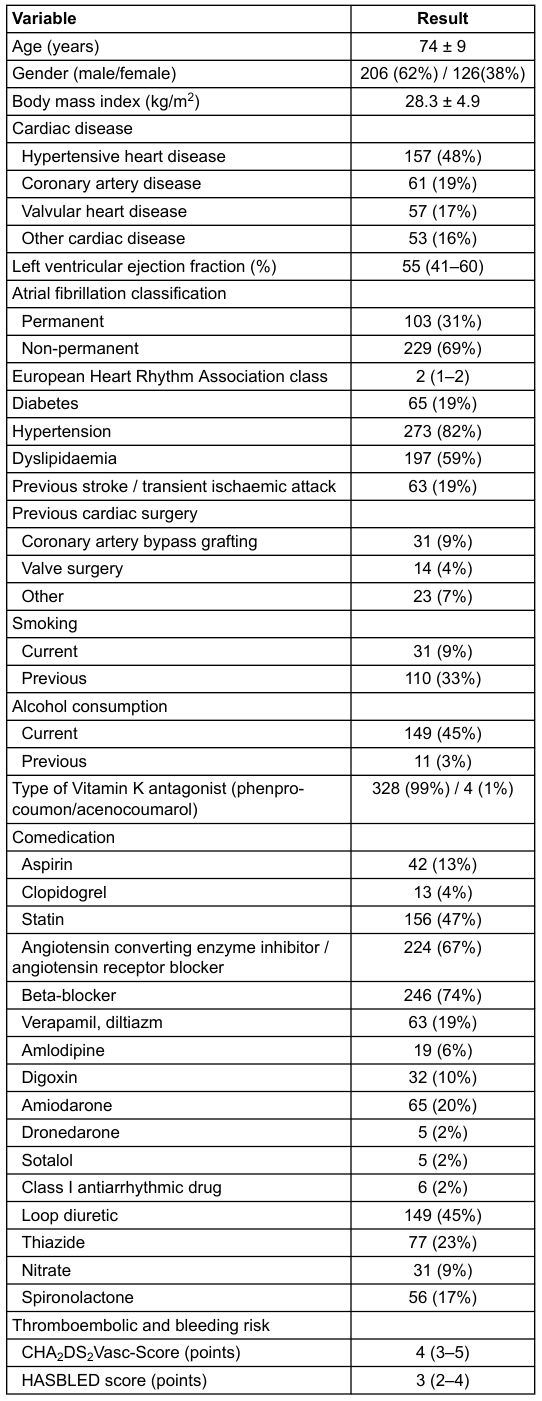
Table 1: Patient characteristics (n =